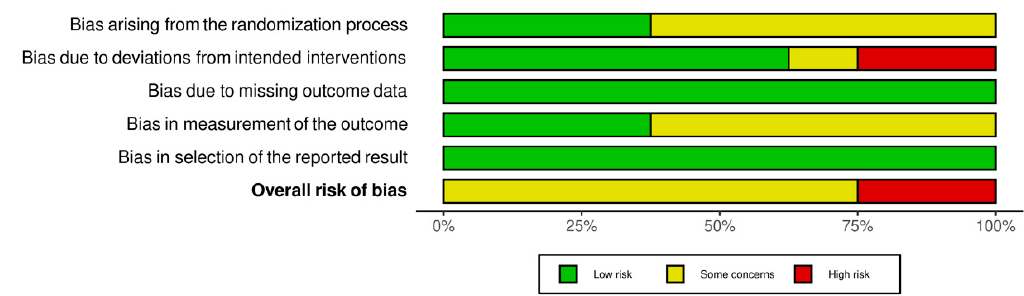
Figure 3. Percentages of risk bias in randomized control trials (RCTs, green: low bias risk; yellow: some concerns; red: high bias risk).